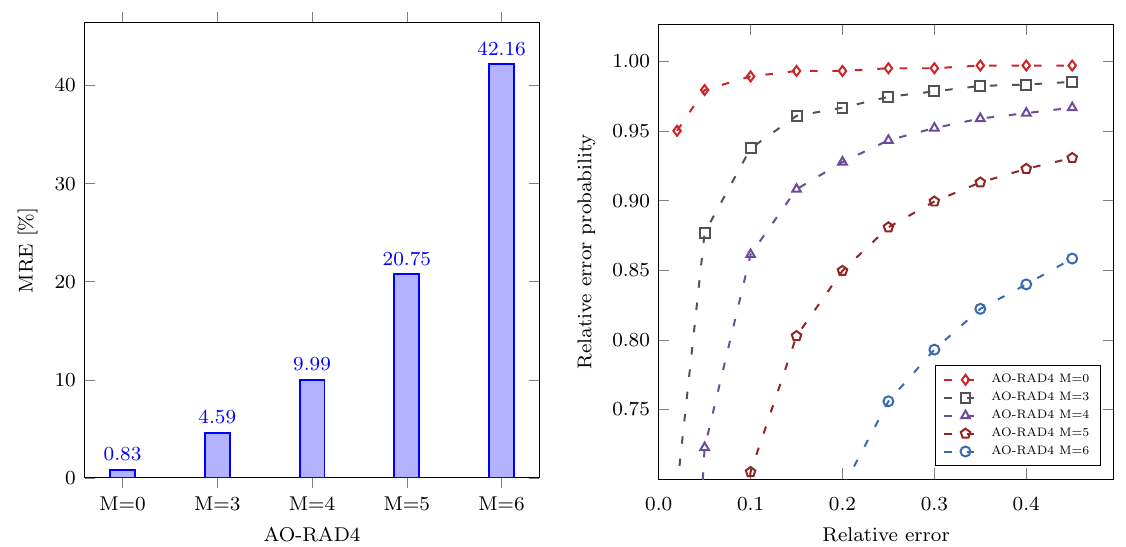
Figure 4. Error analysis of an approximate odd radix-4 (AO-RAD4) multiplier for different values of parameter M. Left : mean relative error (MRE); right : the probability that the relative error is smaller than a specific